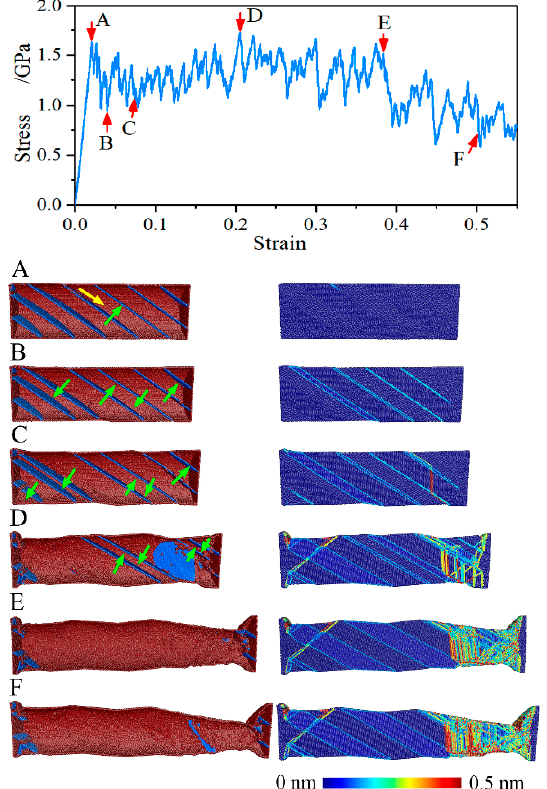
Figure 9. Tensile stress-strain curves and snapshot corresponding to labeled points of the NT Au nanowire with θ = 54.74° and λ = 2.83 nm. On the left panel, the atoms are colored according to the CNA, where the atoms with FCC lattice are hid. On the right panel, the atoms are colored according to the SVA, where the atoms outside of the thresholds are visible and are drawn in saturated colors. Yellow and green arrows denote the direction of dislocations slide and CTBs migration, respectively.